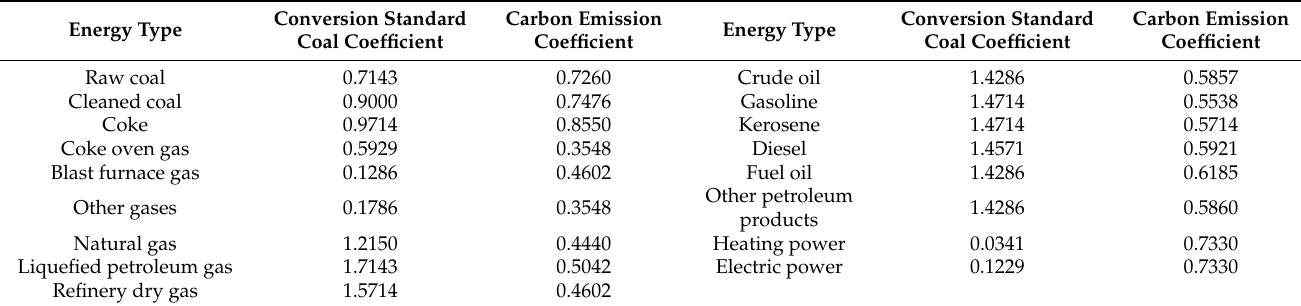
Table 1. Carbon emission coefficient of various energy